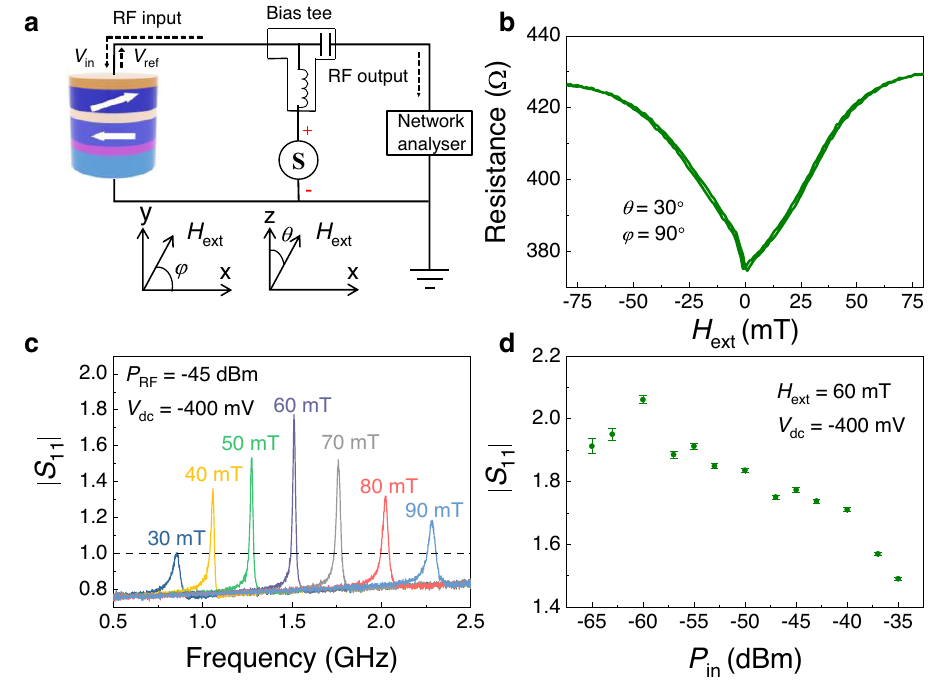
Fig. 1 | Microwaveampli fi cationwith| S 11 |measurement. a A schematicdiagram ofthemeasurementsystems.Inset:Cartesiancoordinatesystem,withadescription ofthedirectionoftheappliedmagnetic fi eld( H ext )andtheindicationofpolar θ and azimuthal angle φ . V in and V ref are the input and output voltage, respectively. The longandshortin-planeaxesoftheMTJcoincidewiththe x and y -axes,respectively. Forthemeasurements,the fi eldisapplied alongthe θ =30°and φ =90°directions. b Magnetoresistance- fi eld curves of one MTJ device for I dc =10 μ A at azimuthal